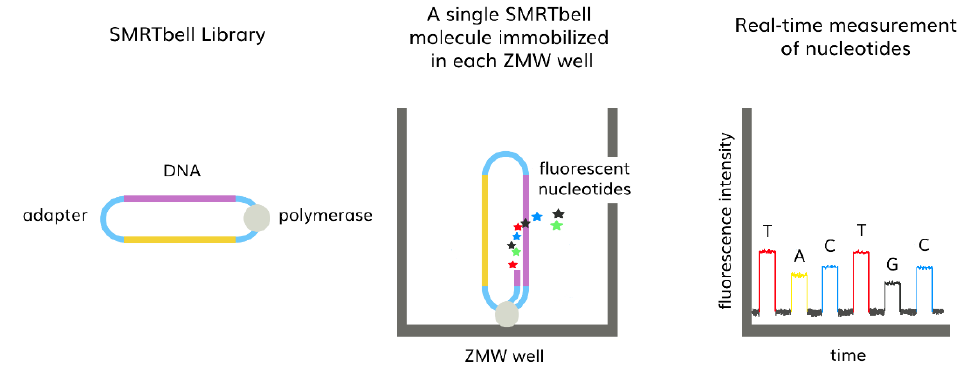
Figure 3. PacBio’s SMRTbell library base calling in SMRT cell containing millions of ZMW wells. Anchored polymerase incorporates the nucleotides, emitting light that is measured in real-time. A base-calling algorithm translates the light into DNA sequence.